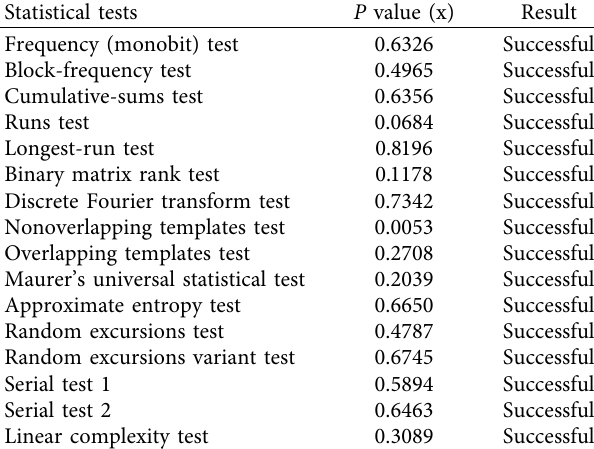
Overlapping templates